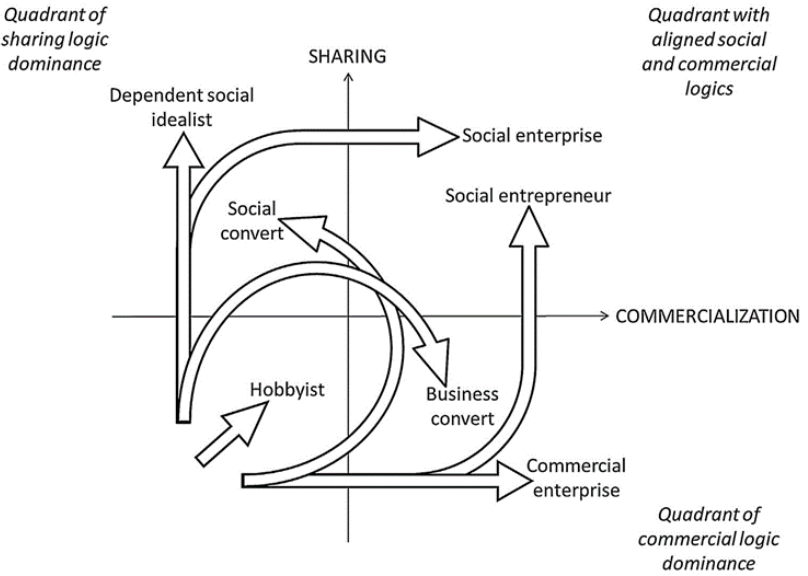
Fig. 1. Development trajectories of maker initiatives in terms of commercialization logics according to Langley, Zirngiebl et al.